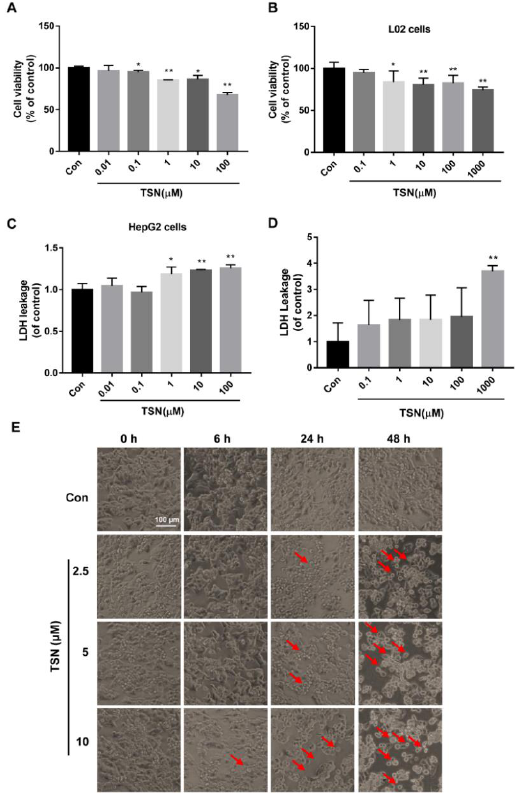
Figure 1. TSN induced cell damage in HepG2 and L02 cells. HepG2 and L02 cells were treated with TSN at various concentrations for 24 h. Cell viability of HepG2 cells ( A ) and L02 cells ( B ) was determined using CCK-8 assay kit. The cell culture supernatants of HepG2 cells ( C ) and L02 cells ( D ) were collected to measure LDH leakage using an LDH assay kit. ( E ) HepG2 cells were treated with TSN at various concentrations (2.5, 5, 10 µ M) for different time durations (0, 6, 24, 48 h), and cellular morphology was captured under phase-contrast microscopy. Red arrows indicate the cells for which morphology changed, mainly shrinking and rounding. Scale bar: 100 µ m. Data are presented as the mean ± SD of three independent experiments. * p < 0.05, ** p < 0.01 versus